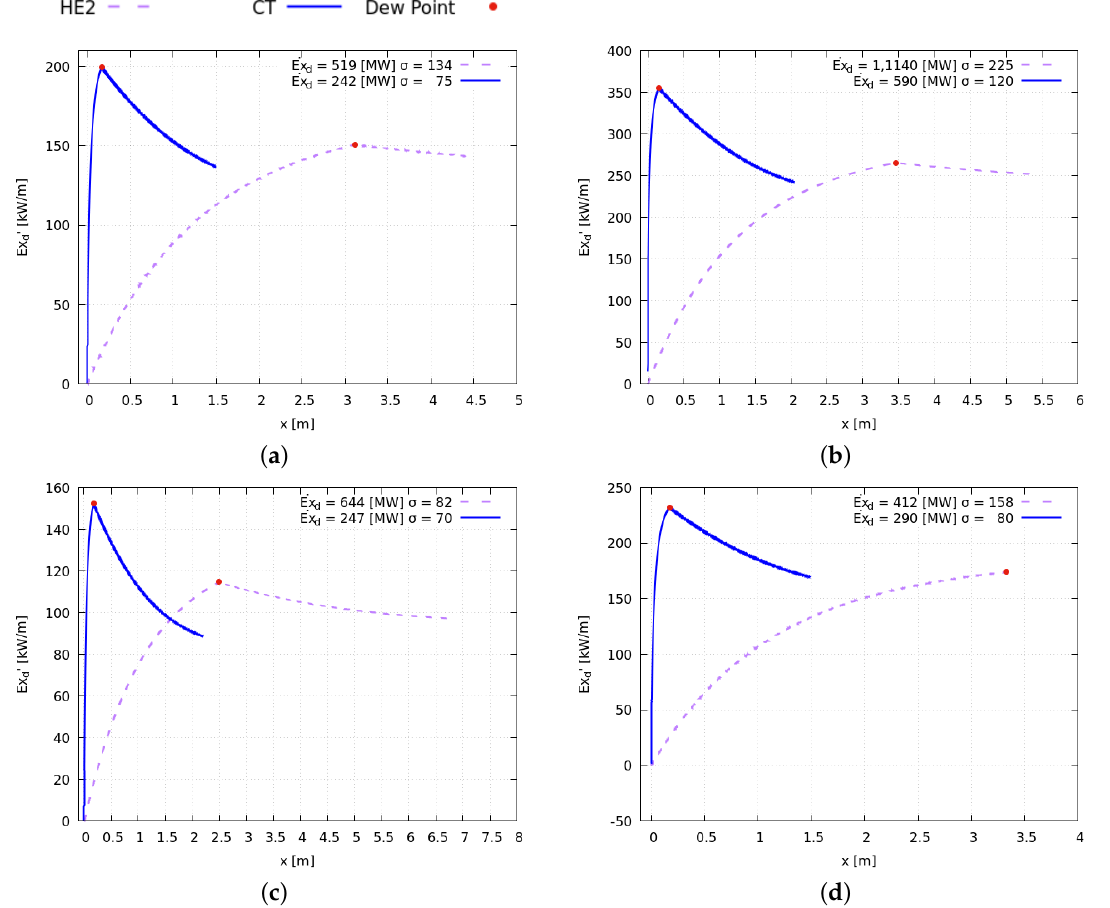
Figure 19. Spatial distribution of exergy destruction rate within HE2 (purple) and cooling tower (blue); the dew point (red point) separates the saturation from the condensation step: SET1 ( a ), SET2 ( b ), SET3 ( c ), and SET4 ( d